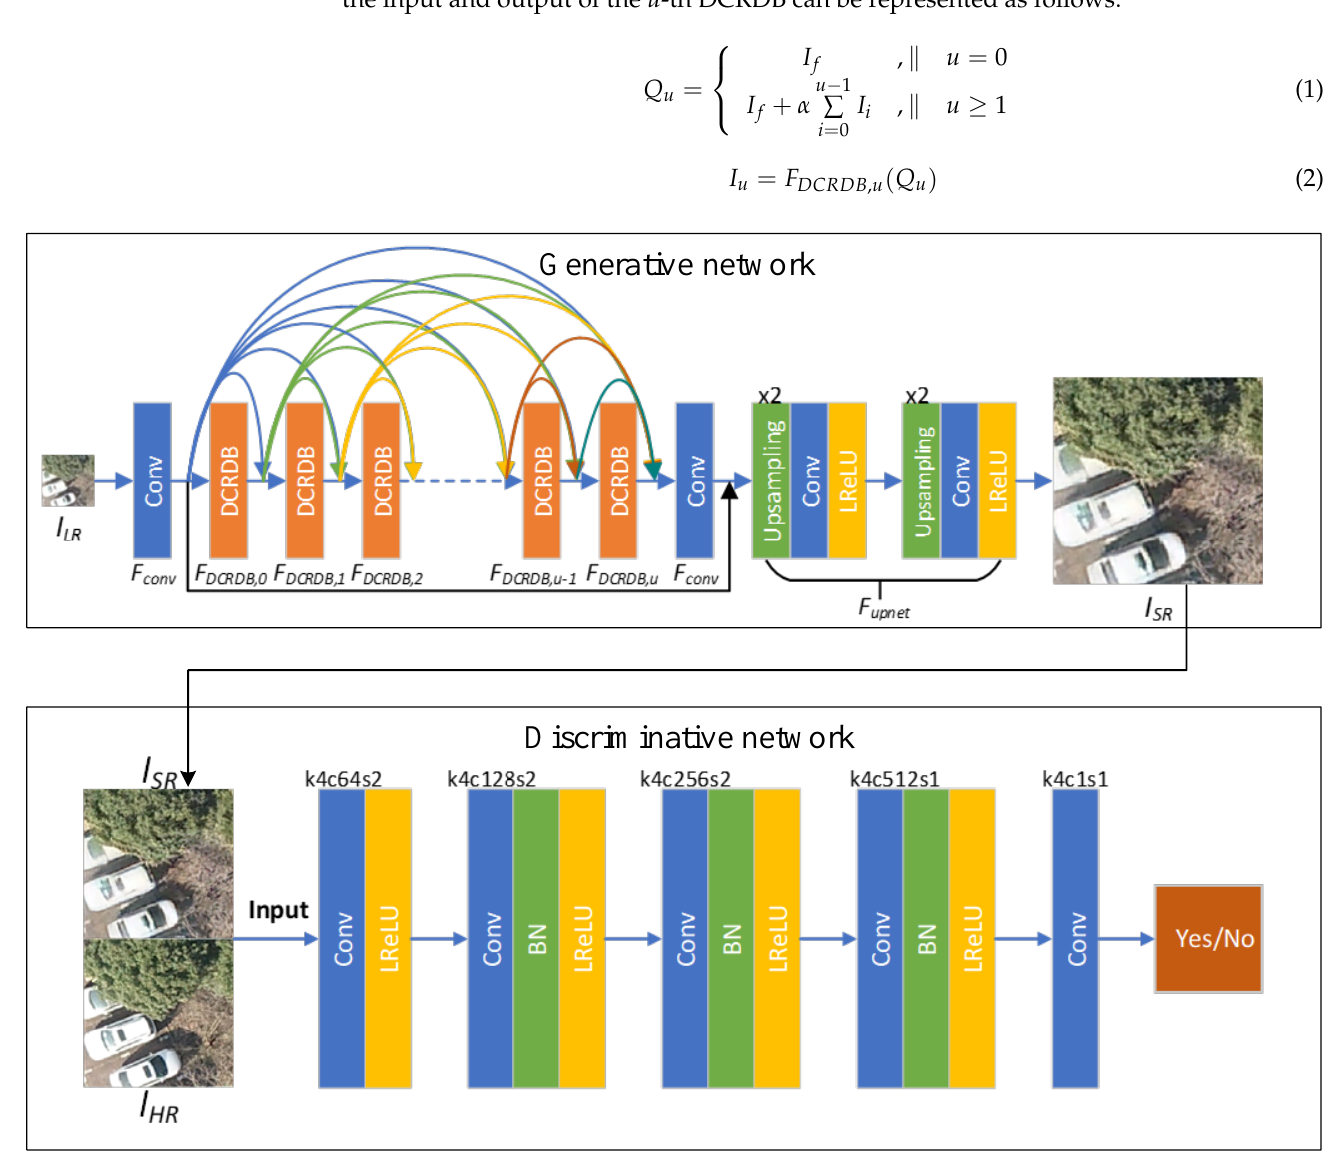
Figure 1. Network structure of NDSRGAN. 𝐼 𝐿𝑅 represents LR images and 𝐼 𝑆𝑅 represents the image generated by the generative network. 𝐹 𝑐𝑜𝑛𝑣 represents the convolutional layer. 𝐹 𝐷𝐶𝑅𝐷𝐵,𝑢 represents the u -th DCRDB module. 𝐹 𝑢𝑝𝑛𝑒𝑡 denotes the upsampling network. 𝐼 𝐻𝑅 represents the original HR image and 𝐼 𝑆𝑅 represents the output image of the generative network. In addition, k represents the convolution kernel size, c represents the number of convolution kernels and s represents stride. The arrows in the figure represent the flow of the feature map.